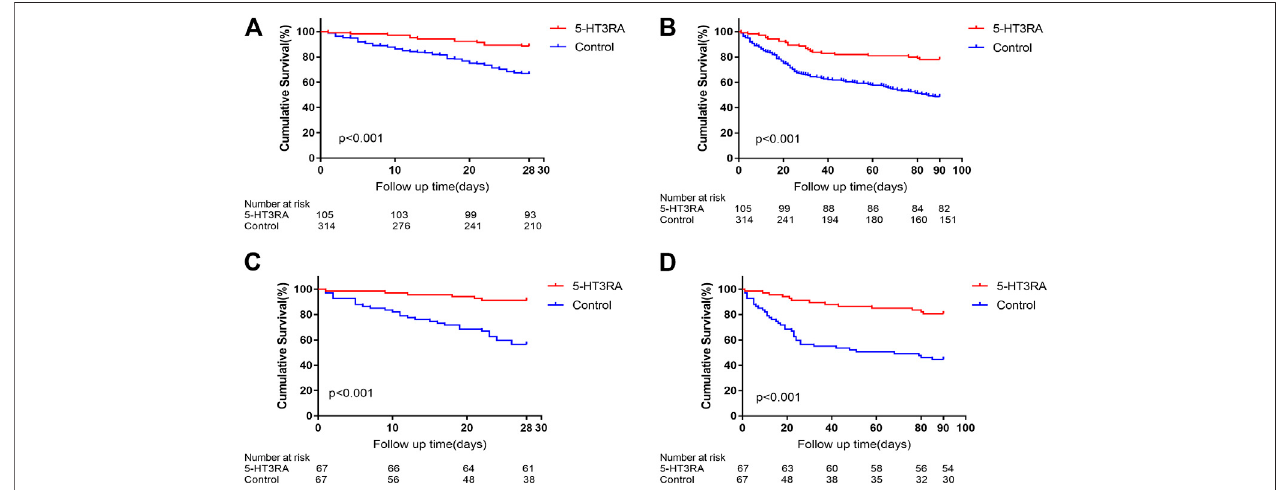
FIGURE1| The28and90 daysKaplan-Meiersurvivalcurvesinpatientswithandwithouttheuse5-HT3receptorantagonists(5-HT3RA). (A) The28 dayssurvivals before propensity score matching (PSM). (B) The 90 days survivals before PSM. (C) The 28 days survivals after PSM. (D) The 90 days survivals after PSM.